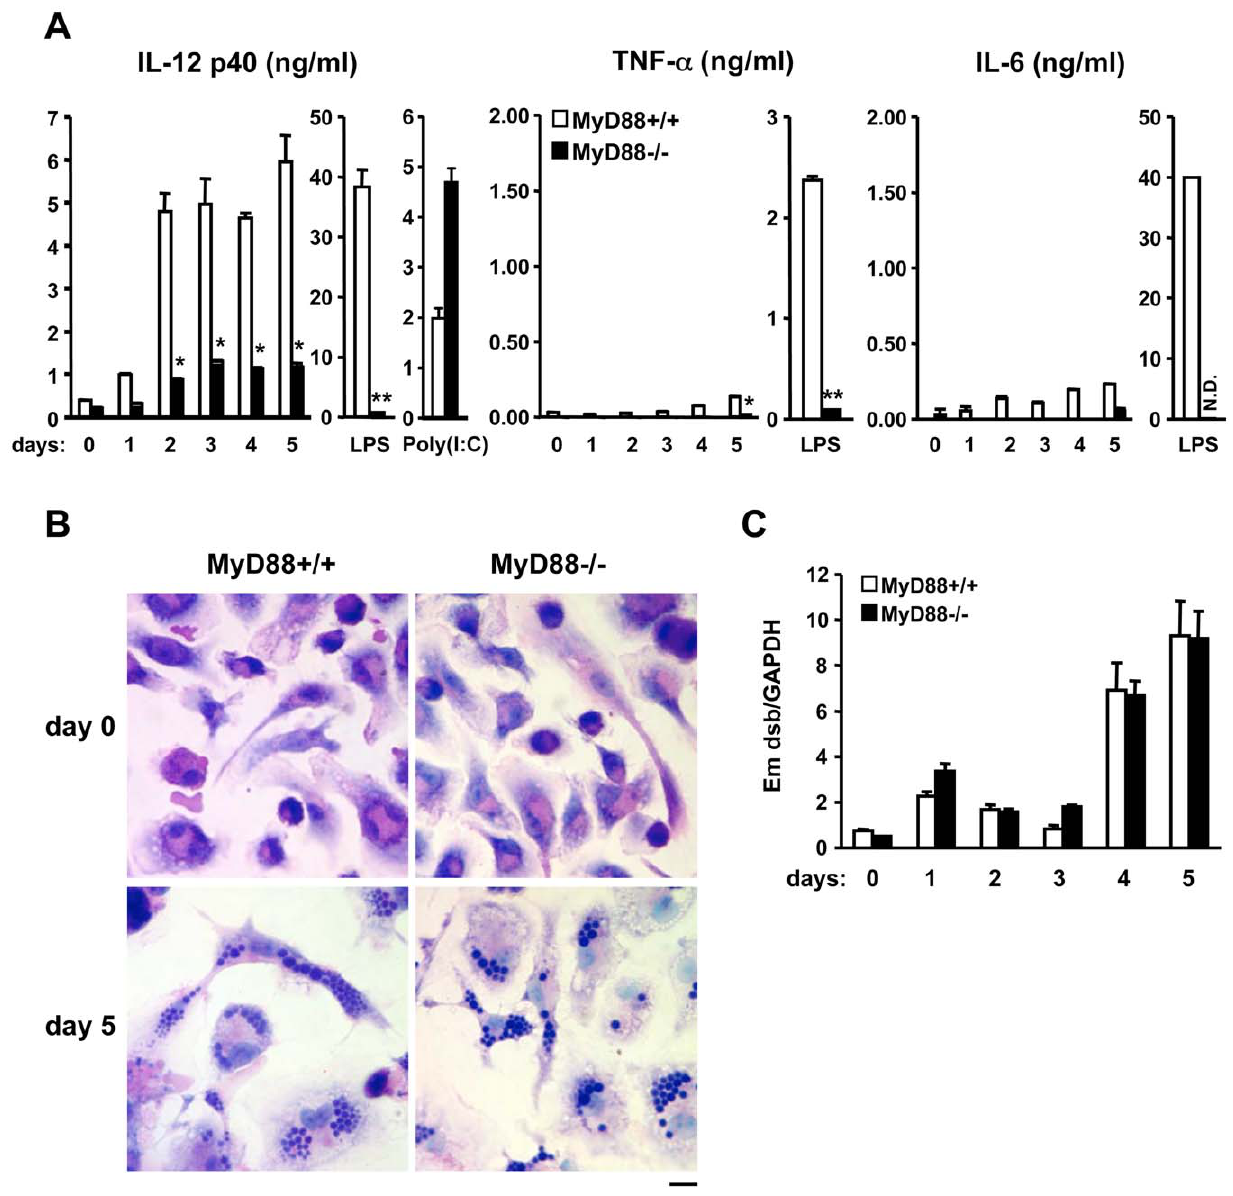
Figure 4. MyD88 is required for IL-12 production in E.muris- infected DCs. Bone marrow-derived DCs from wild-type and MyD88-deficient mice were infected with E. muris for the indicated time period. (A) Cytokine production from infected cells was assessed by ELISA. LPS (10 ng/ml) and poly(I:C) (50 m g/ml) stimulations were used as controls. (B) Infected cells (5 days post infection) were stained by Diff-Quick staining. Scale bar, 10 m m. (C) Bacterial loads in infected cells were quantified by qPCR using primers specific for the E. muris dsb gene. Data were normalized by qPCR data for the GAPDH gene in host genomic DNA. Error bars represent the SD of triplicate samples. The P -values were determined by Student’s t -test (MyD88 + / + vs. MyD88-/-). * P , 0.05. ** P , 0.01. Data are representative of at least three independent experiments in A–C. N.D., not detected.